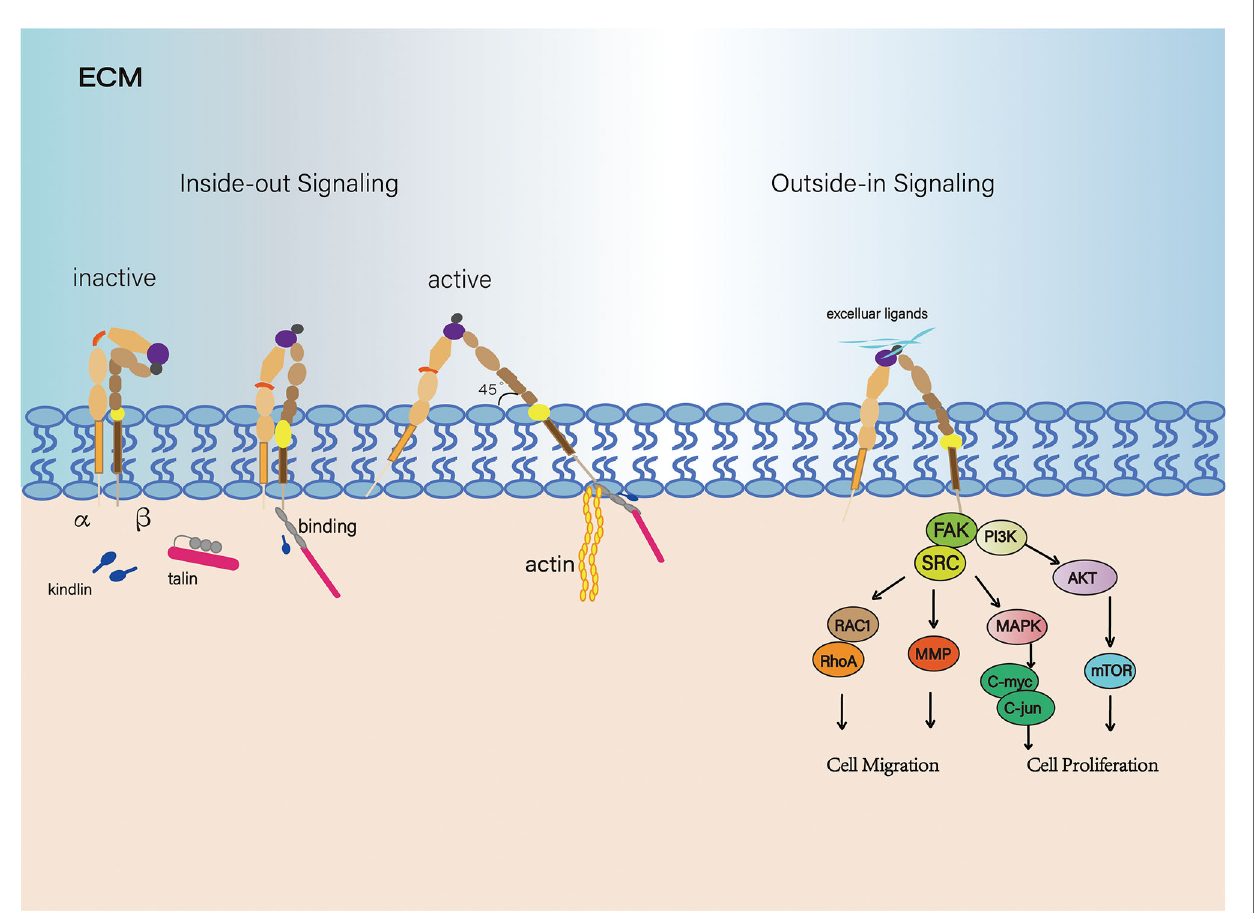
FIGURE 1 | Signal transduction of the integrin family. From an inactive conformation to a low af fi nity, intermediate state that may arise from talin and/or kindlin binding. And in the active state, integrin subunits were separated, forming a 45 degree angle. Integrins are connected to the actin cytoskeleton and can initiate cytoskeletal remodeling (Left). Integrin-controlled cell migration is largely mediated by signaling pathways involving members of the focal adhesion kinase (FAK)-SRC family kinase. Integrins are ligated and initiate multiple downstream